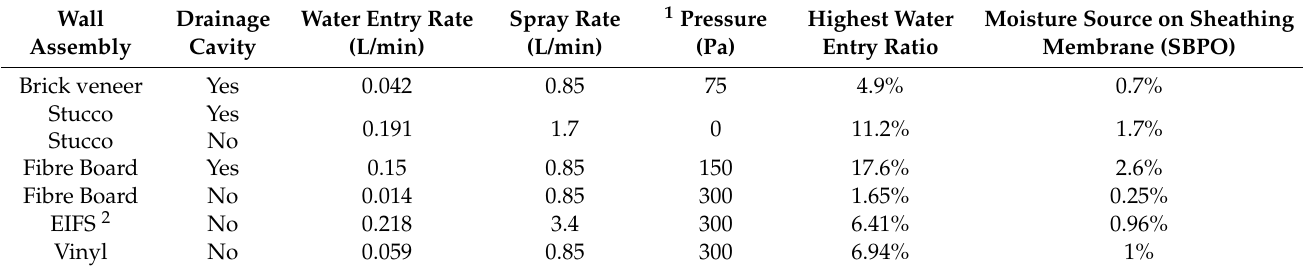
Table 5. Water entry rate of different types of wall assemblies (Data from reference